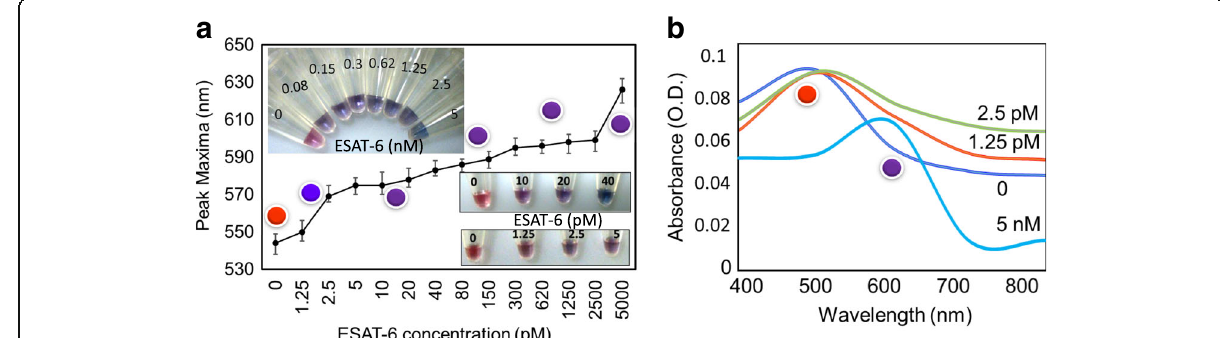
Fig. 6 Detection limit of ESAT-6 by the antibody-based colorimetric assay. a Graphical representation for the detection of ESAT-6. Different concentrations of ESAT-6 was mixed with 60 nM of antibody, and after 30 min of incubation, GNP was added. Then, 800 mM of NaCl was added to induce the color change. ESAT-6 protein was titrated from 1.25 pM to 5000 pM. Photographs were taken by the digital camera as in figure inset. b Spectral changes at the wavelength from 400 to 800 nm. Peaks were indicated with the respective colored spheres